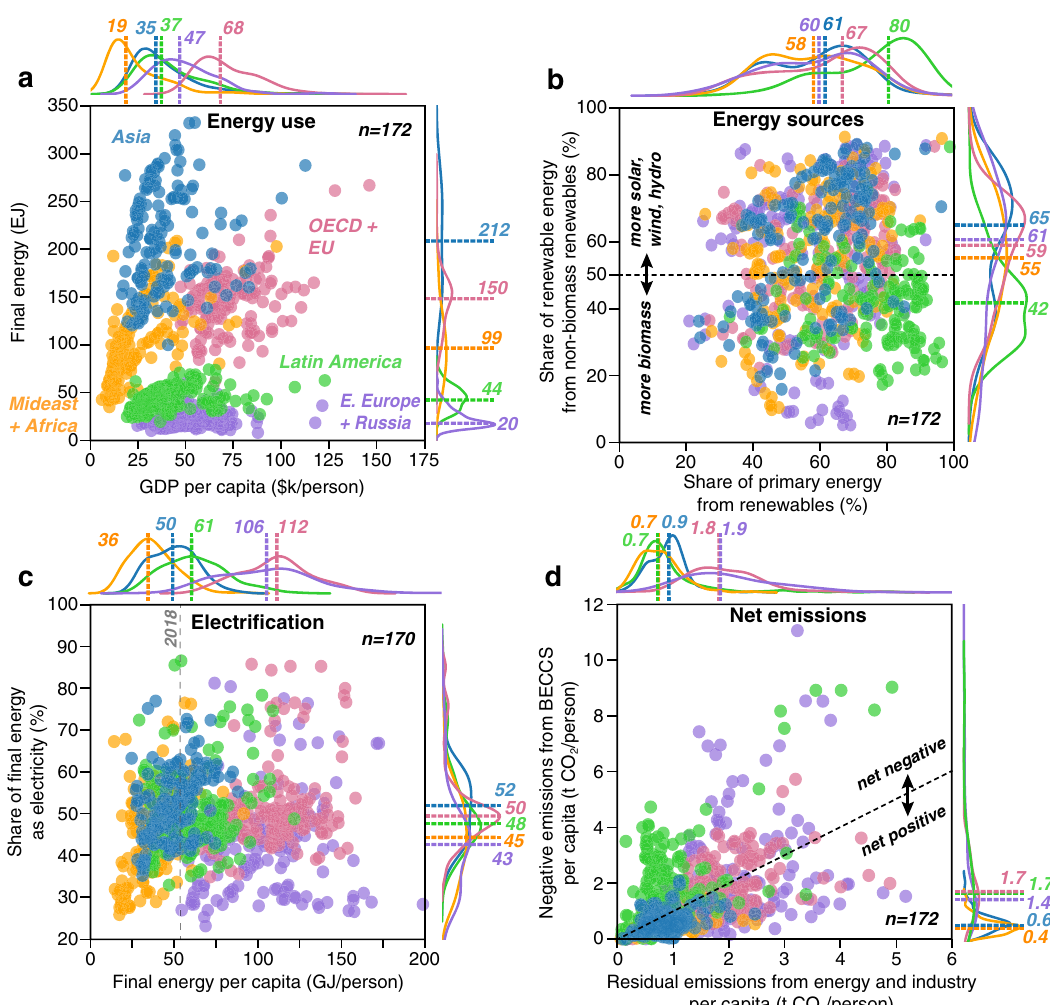
Fig. 2 Characteristics of regional energy systems and emissions when global emissions reach net-zero. Scenarios that reach net-zero emissions globally ( n = 172 scenarios with all regions) show regional differences in energy use ( a ), energy sources ( b ), electri fi cation ( c ), and net emissions ( d ). Points represent individual scenarios, with a frequency of scenarios shown along each axis for each region (Asia = blue, Latin America = green, Middle East + Africa = orange, OECD + EU countries = pink, and Eastern Europe + Russia = purple). Colored dashed lines and values indicate medians for each region. Gray dashed lines indicate global reference values for the year shown in